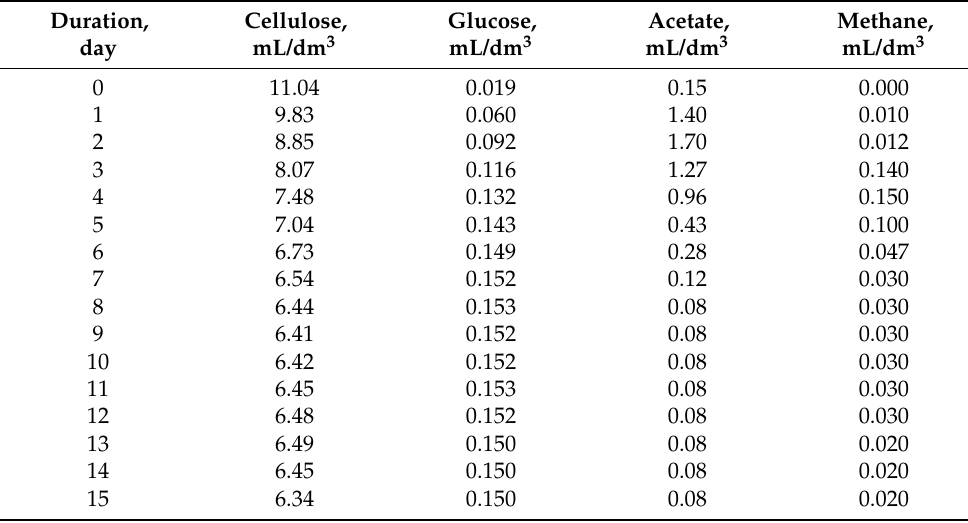
Table 2. Batch experiments with 35 mL/dm 3 organic